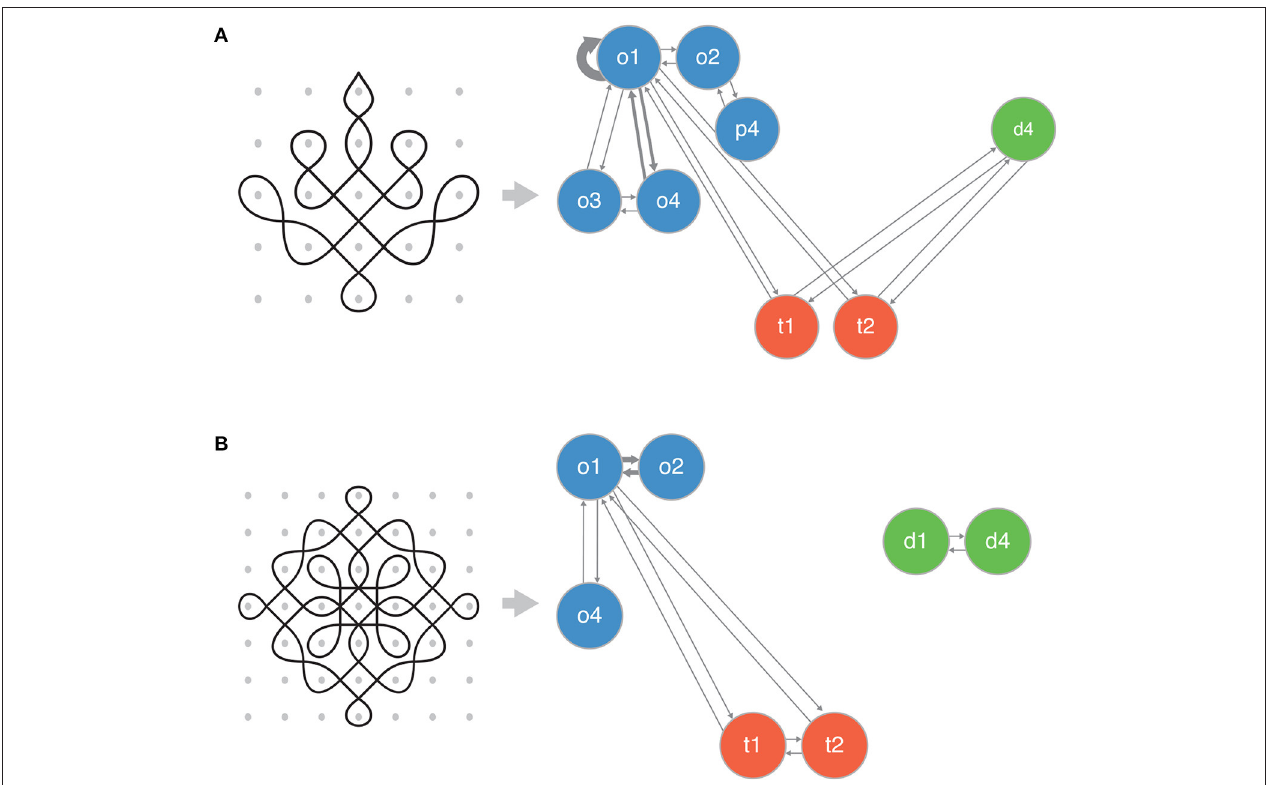
FIGURE 3 | Example of a transition (count) networks for kolam drawings. Each row (A,B) corresponds to an example kolam drawing from an artist. The edge width represents the count, whereby an increased width implies a higher transition count. The three colors represent the different geometric spaces: orthogonal (blue), diagonal (green), and transitional (orange). Each node represents a gesture used by the artist from the lexicon of gestures (see Figure 1 ).